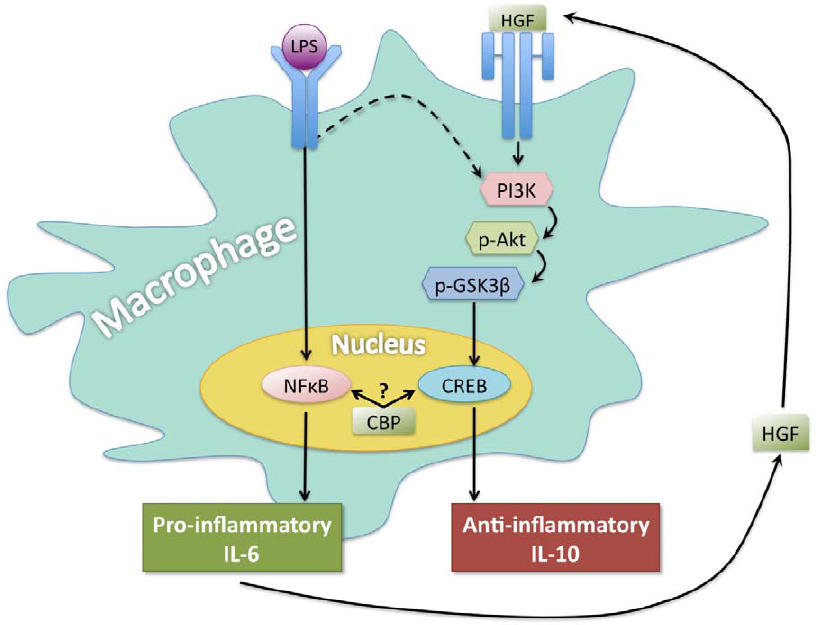
Figure 7. Proposed mechanism of HGF-mediated suppression. The canonical signaling pathway of LPS-TLR engagement leads to NF k B dependent pro-inflammatory cytokine production through the interaction of CBP with NF k B. However, TLR signaling has also been shown to weakly activate alternative signaling through PI3K, resulting in phosphorylation and inactivation of GSK3 b , subsequent sequestration of CBP from NF k B to phospho-CREB, and resultant anti-inflammatory (IL-10) production[7]. Our results show that the presence of HGF enhances the IL-10 pathway. We postulate that in order to resolve inflammation, the generation of IL-6 by LPS-TLR signaling leads to the production of HGF, ultimately leading to the inhibition of inflammation. Hence, we propose HGF acts as an internal rheostat for resolving acute phase inflammatory